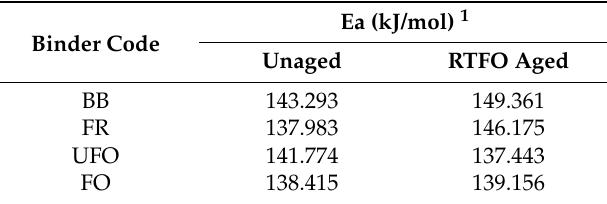
Figure 14. Superpostioning of unaged base binder (BB) ( a ) isotherms and ( b ) horizontal shifting using shift factors. Table 8. Activation energy E a of